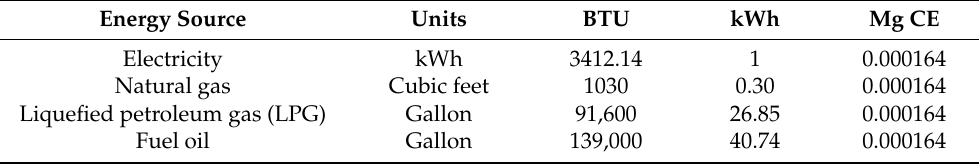
Table 1. Values for converting energy source units to kg of carbon equivalents (kg CE). Energy Source